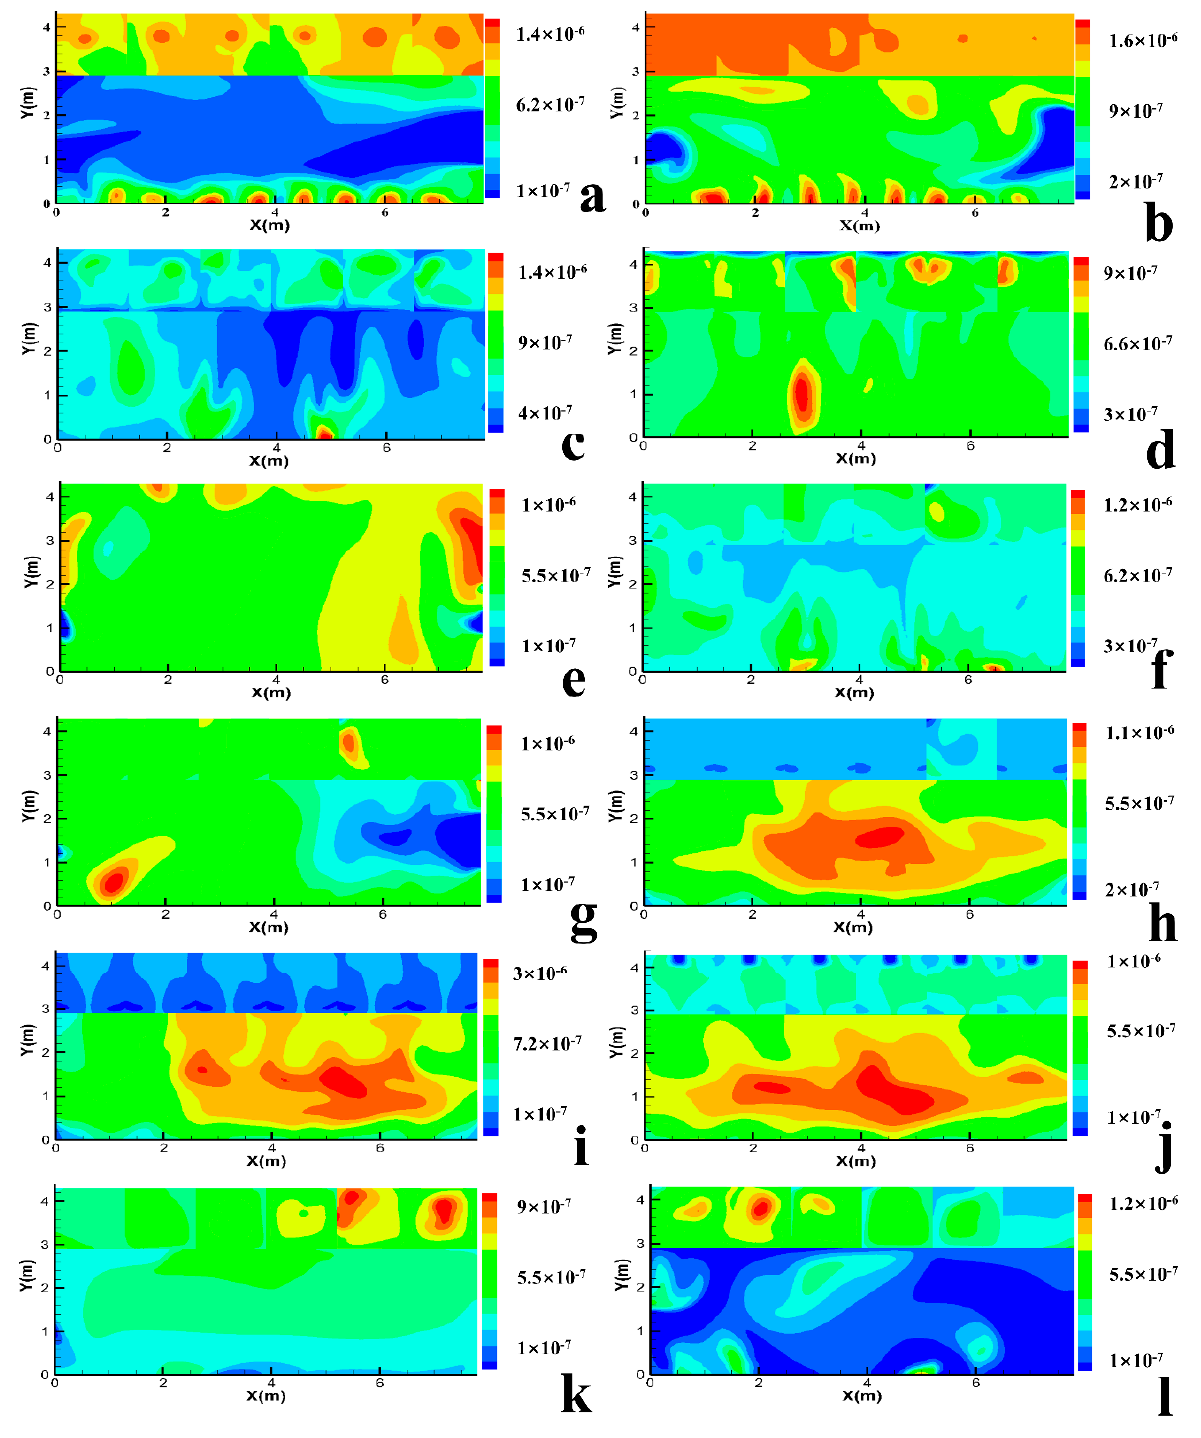
Figure 3. Ammonia concentration cloud diagram in different cases (Z = 1.5 m, ACH = 5): ( a – l ) MV-1–IJV-7. ( a ): MV-1; ( b ): MV-2; ( c ): PV-1; ( d ): PV-2; ( e ): PV-3; ( f ): IJV-1; ( g ): IJV-2; ( h ): IJV-3; ( i ): IJV-4; ( j ): IJV-5; ( k ): IJV-6; ( l ): IJV-7.